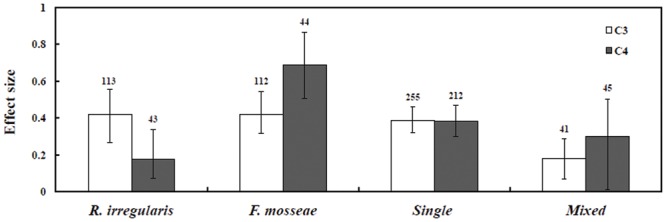
Effect sizes of AMF species-categorical analysis. Error bars are means bias CIs. Where the CIs do not overlap the horizontal dashed lines, the effect size for the parameter is significant at P < 0.05. A number of studies included for meta-analysis are mentioned above the bar.